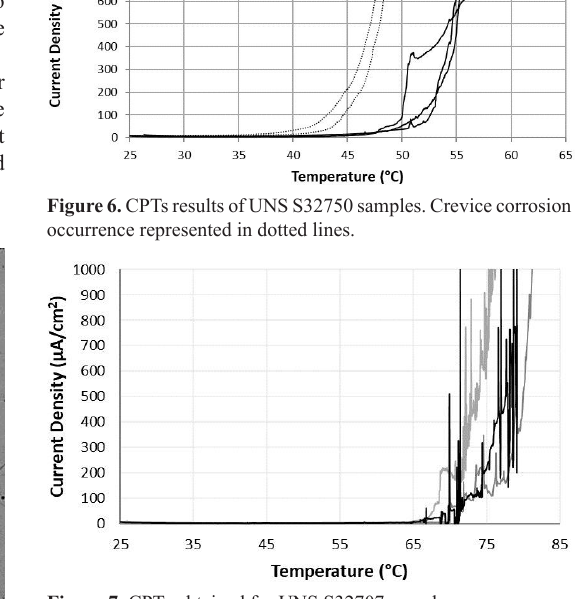
Figure 7. CPTs obtained for UNS S32707 samples.